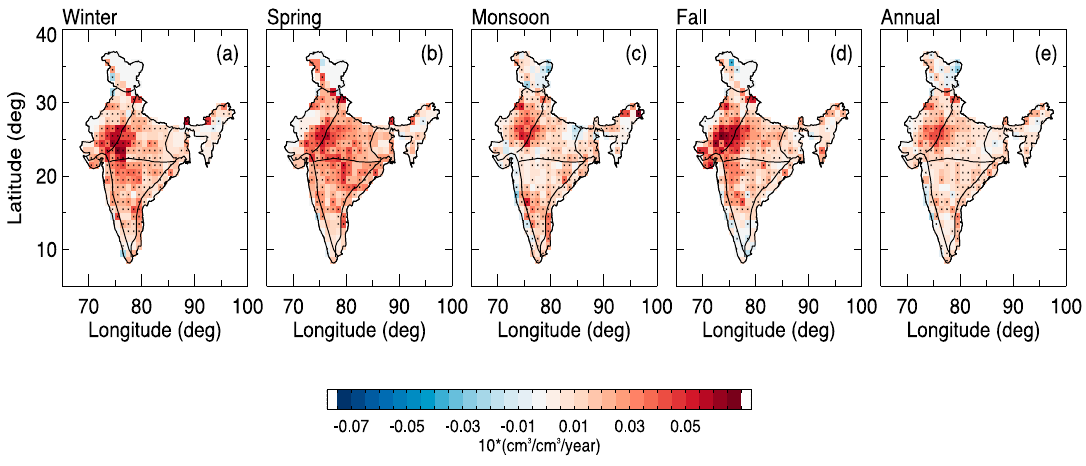
Figure 9. Spatial distribution of AMSR soil moisture trends for ( a ) winter, ( b ) spring, ( c ) monsoon, ( d ) fall, and ( e ) annual from June 2002 to April 2017. Solid black marks indicate regions where the trends are significant at the 95% confidence level based on the Mann–Kendall test.